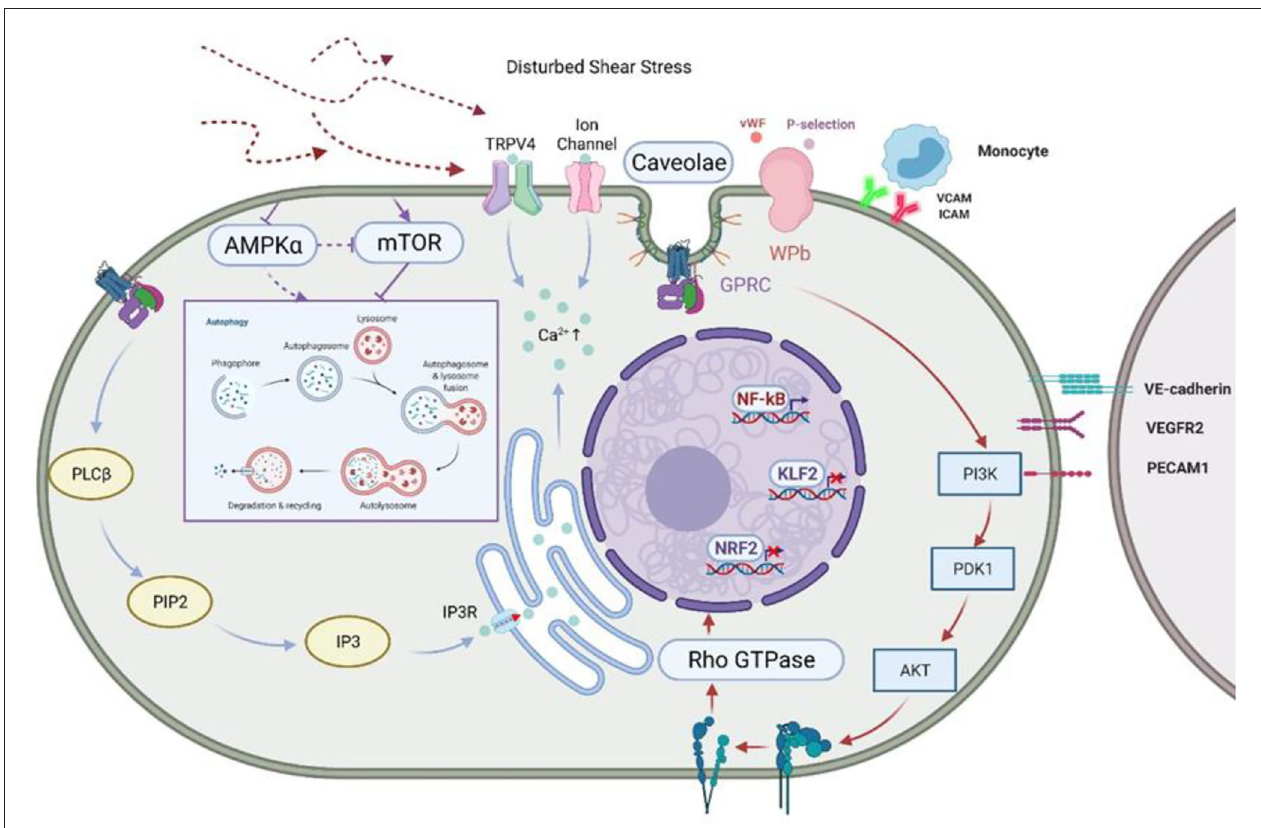
FIGURE 2 | Disturbed shear stress activates ECs and inhibits autophagy. Shear stress inhibits AMPK α and activates mTOR, two classical “autophagy switches,” to inhibit autophagy. Glycocalyxin acts as the first pass-through sensor in the face of shear stress, converting mechanical signals into physiological signals, which are then passed on through ion channels, caveolae, and integrins, amongst others (42). Shear stress regulates endothelial cell behavior through GPCR and the mechano-sensing complex formed by VE-cadherin and VEGFR-2/VEGFR3, which stimulate PI3K/AKT signaling and activate integrins in an “outside-in” manner, leading to the cis-activation of GTPases and the regulation of the expression of various transcription factors ( 28). This leads to the cis-activation of GTPases and promotes the expression of transcription factors. In addition, stimulated VE-cadherin and VEGFR2/VEGFR3 form a mechano-sensing complex that transmits signals to neighboring cells. At the same time, Ca 2 + is stored in the endoplasmic reticulum via IP3R by the PLC β /PIP2/IP3 signaling pathway in response to perturbed shear stress. Activation of non-selective cation channels such as TRPV4 and K 2 + Ca leads to the influx of more Ca 2 + and hyperpolarizes the membrane. At the same time, shear stress regulates platelet behavior by inducing the release of P-selectin and vWF from WPBs (46). AMPK, AMP-activated protein kinase; mTOR, mammalian target of rapamycin; GPCR, G protein-coupled receptors; VEGFR, vascular endothelial growth factor receptor; PI3K, phosphatidyl inositol 3 kinase; IP3R, inositol trisphosphate receptor; PLC β , Phospholipase C Beta 3; PIP2, phosphati-dylinositol-4,5-bisphosphate; IP3, inositol triphosphate; TRPV4, transient receptor potential; K 2 + Ca , Ca 2 + -sensitive K channels; WPBs, Weibel-Palade bodies; vWF, von Willebrand